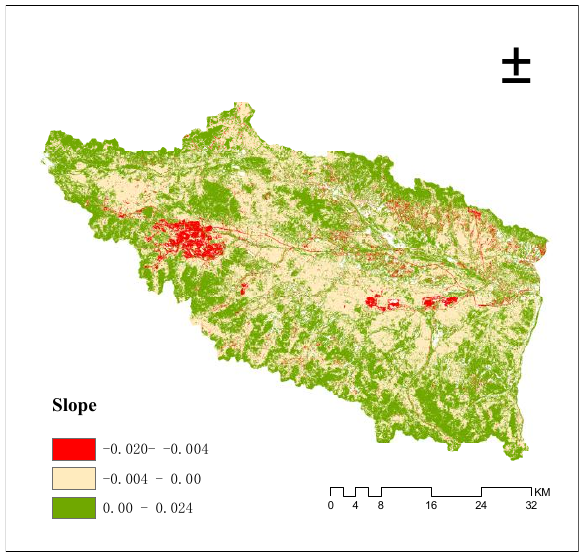
Figure 4. Slope of FVC in the Muli region from 2010 – 2016.